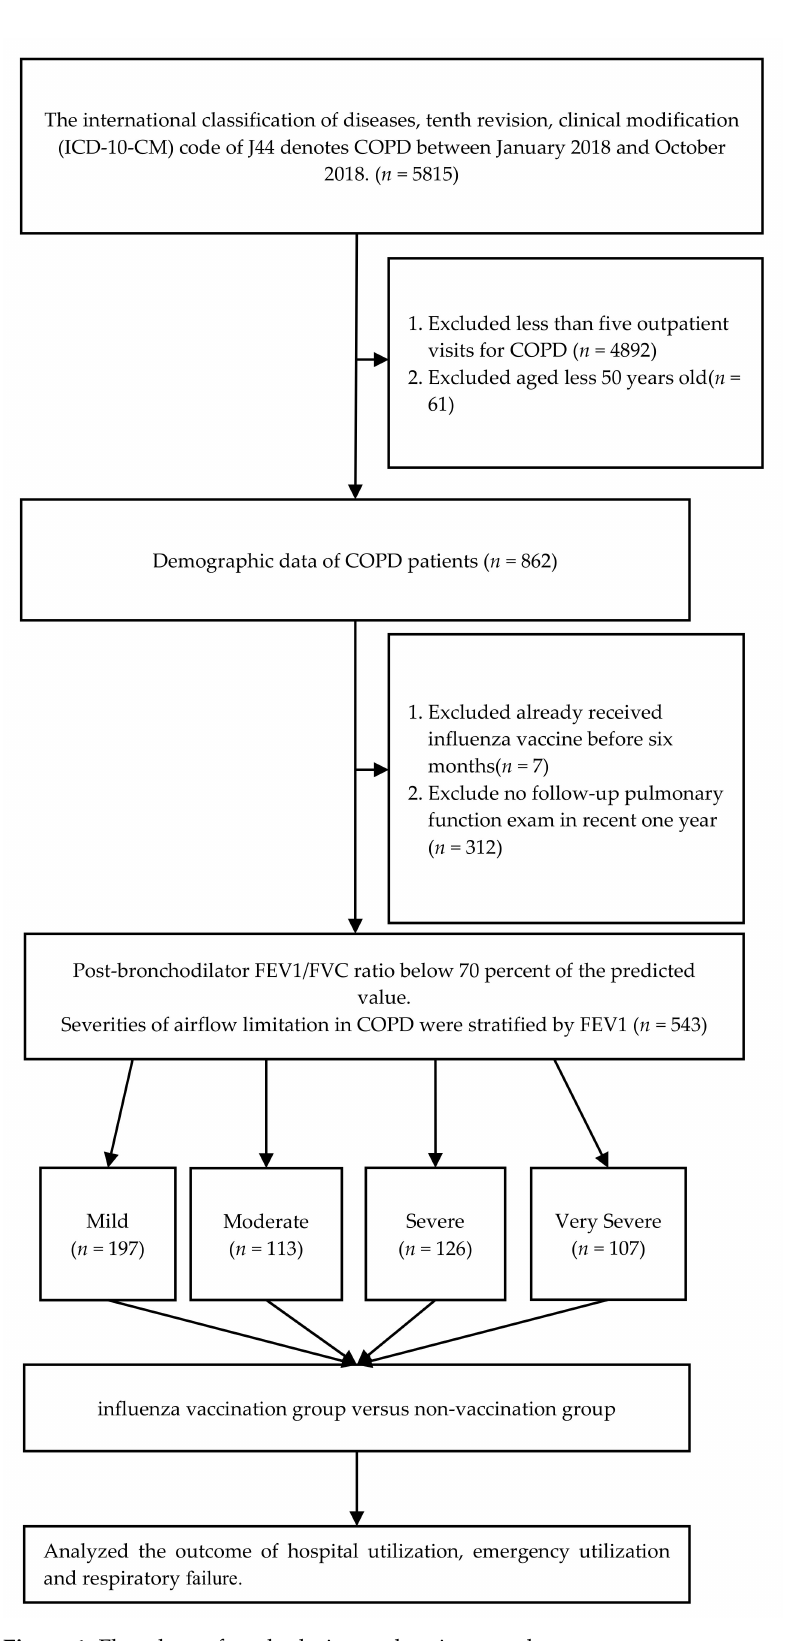
Figure 1. Flowchart of study design and patient